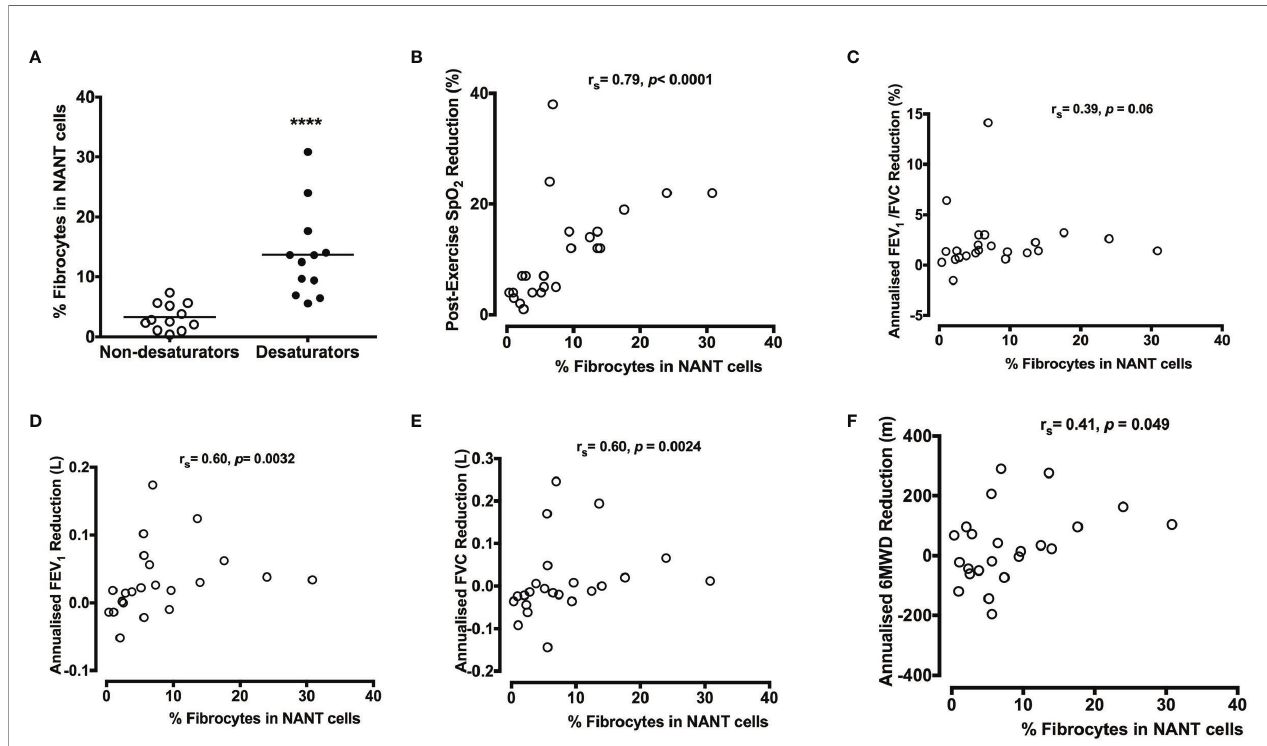
FIGURE 3 | Higher percentage of circulating fi brocytes with greater lung function decline in COPD desaturators (A) . NANT cells were isolated from peripheral blood of non-desaturators (n = 12) and desaturators (n = 12) and the percentage of collagen I + /CD45 + fi brocyte in freshly isolated NANT cells on day 0 was determined by fl ow cytometry. Horizontal lines represent the mean values for each group. (B – F) All participants performed 6-minute walking tests at the beginning and during the 5- year follow-up. The correlation between the percentage of fi brocytes and the extent of post-exercise reduction in SpO 2 at baseline (B) , annualized change in FEV 1 / FVC ratio (C) , FEV 1 (D) , FVC (E) and 6MWD (F) are shown. The differences between non-desaturators and desaturators were determined by Mann-Whitney test and the correlation was determined by Spearman ’ s rank correlation. **** P < 0.0001. COPD, chronic obstructive pulmonary disease; NANT cells, non-adherent non-T fraction of peripheral blood mononuclear cells; FEV 1 , forced expiratory volume in 1 second; FVC, forced vital capacity; %pred, percent of predicted value; Ex, exercise; SpO 2 , peripheral blood oxygen saturation; 6MWD, 6-minute walking